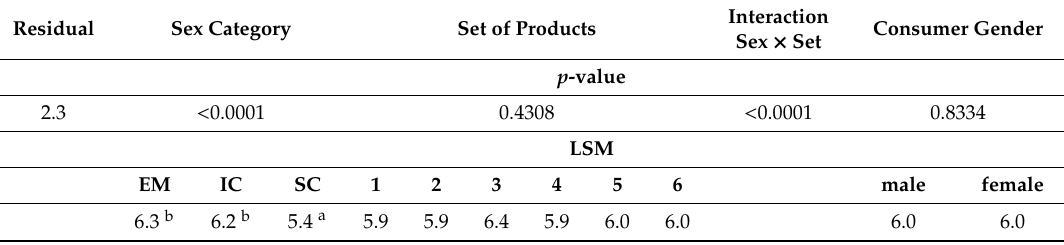
Table 2. Analysis of variance for the pancetta sensory acceptability